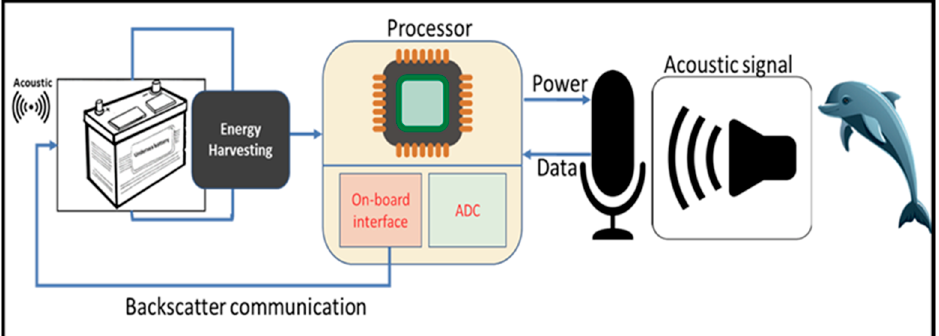
Figure 9. Battery-free sensor node approach for UIoT nodes.